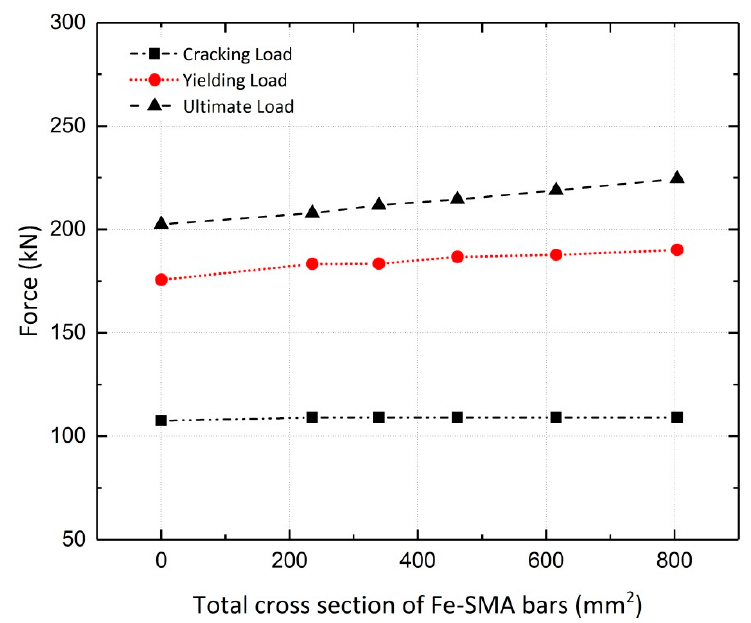
Figure 30. Effect of activated Fe-SMA bars on load–deflection behavior of girders compared to the reference.